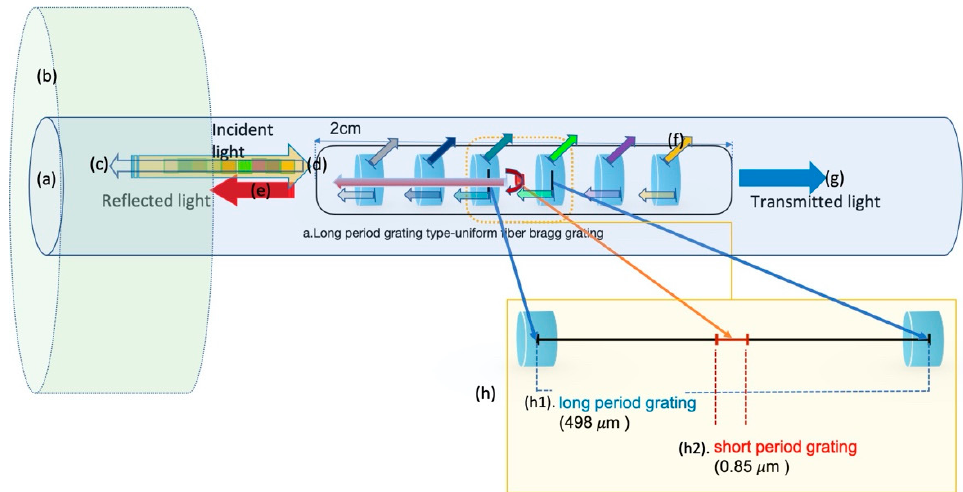
Figure 3. Bragg grating sensor structure and principle. ( a ) fiber optic core; ( b ) fiber optic cladding; ( c ) core reflected light of the long- and short-period Bragg gratings; ( d ) incident light; ( e ) reflected light; ( f ) cladding mode scattering of long-period grating; ( g ) transmitted light; ( h ) long- and short-period grid structure diagram; ( h1 ) long-period grating space; and ( h2 ) short-period grating space.